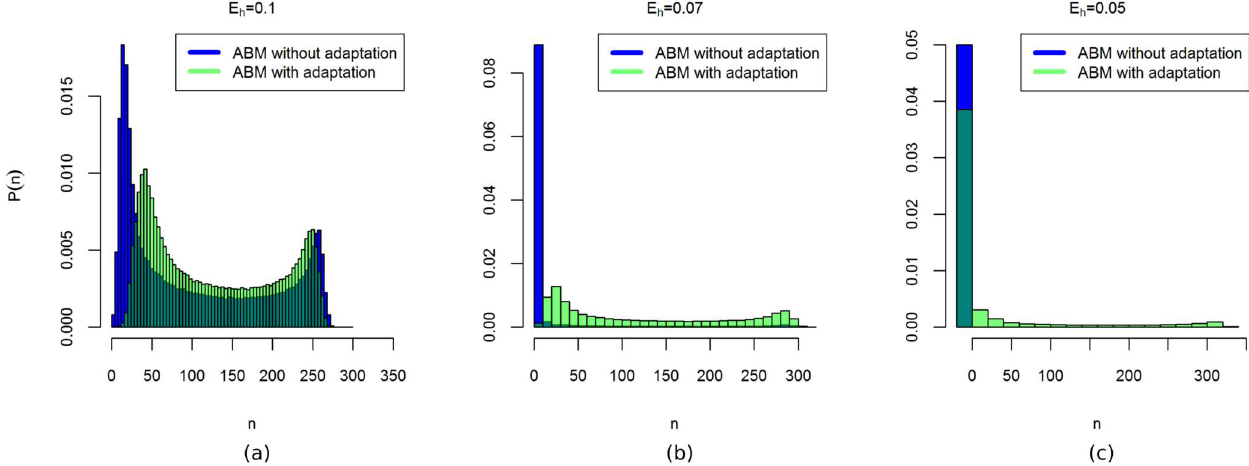
Fig 8. Time-averaged histograms of the number of agents n , for selectedvalues of E h . The peaks at n = 0 correspondto the population going